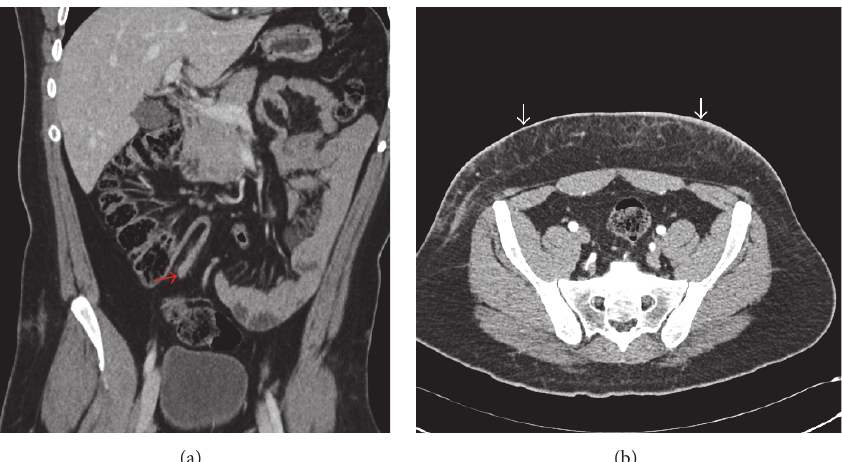
Figure 1: (a) CT abdomen, coronal view, showing inflamed appendix (red arrow). (b) CT abdomen, transverse view, showing subcutaneous fat stranding of lower anterior abdominal wall (white